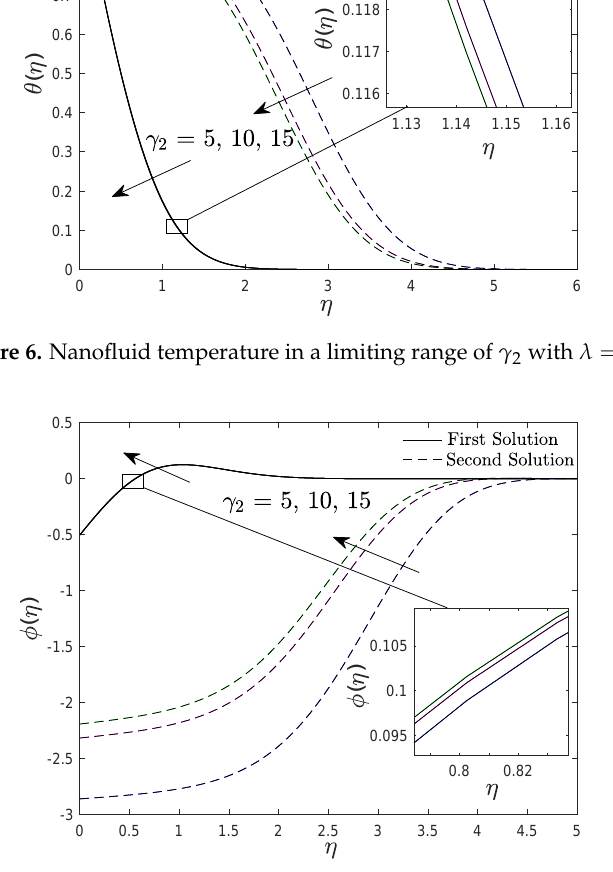
Figure 7. Nanoparticles volume fraction profile in a limiting range of γ 2 with λ = − 1,1.